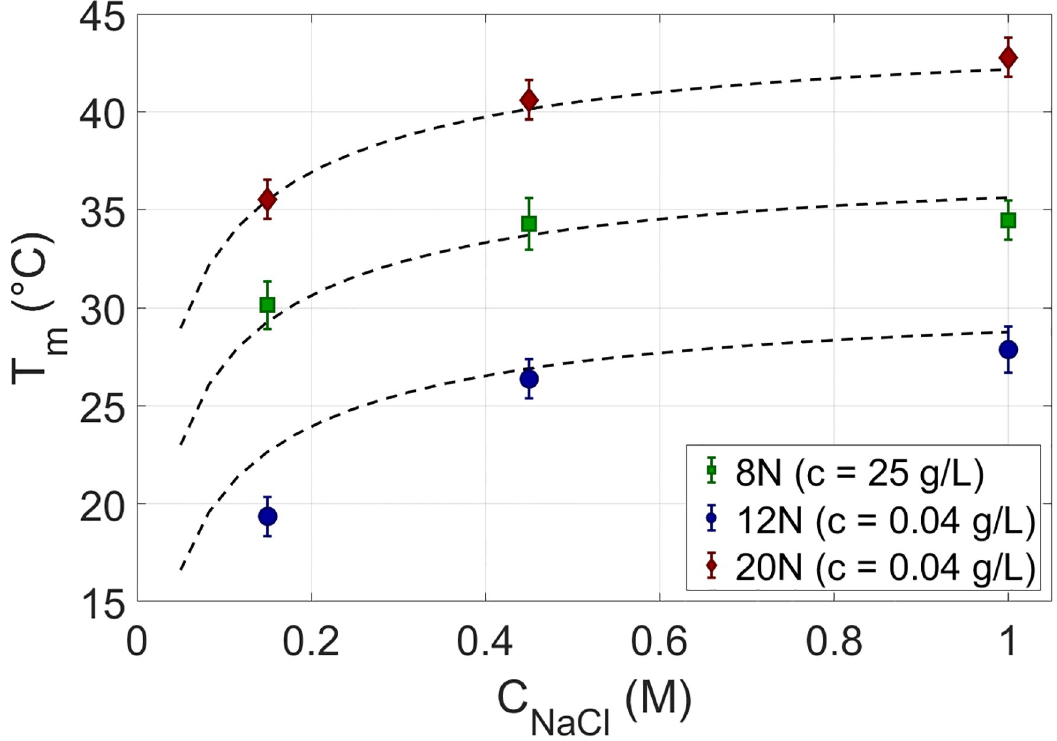
Fig 7. Melting temperatures for rsDNA: Theory vs experiment. Comparison of measured and predicted T m for rsDNA solutions. Symbols: experimental T obtained from the melting curves of 8N, 12N and 20N (Fig 3), as function of salt, c m specified in the legend. Dashed lines: theoretical predictions of Eq (7).